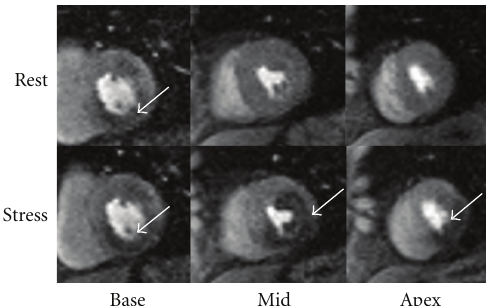
Figure 1: CMR with pharmacologic stress. An example of an adenosine stress CMR in a diabetic patient presenting with new onset chest pain. Resting first-pass perfusion images (top panels) are shown above the corresponding stress perfusion images (bottom panels) in the basal, midventricular, and apical short-axis views. There are inferior and anterior resting perfusion defects in the basal short-axis slice, but with stress this patient develops a severe inferior perfusion defect extending to the lateral wall and septum in the midventricle and apex. On cardiac catheterization (not shown), this patient had multivessel